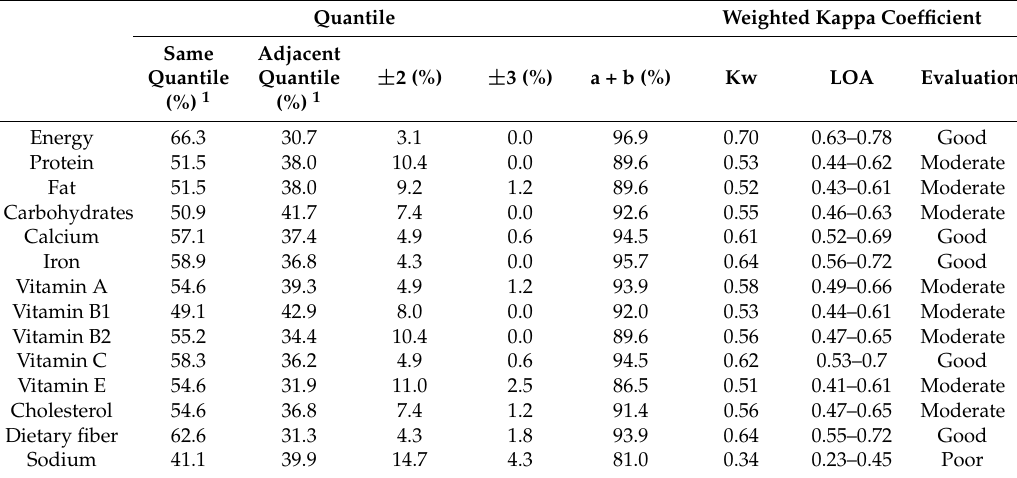
Table 3. Agreement between the DR and WDDR by energy and nutrient intake 1 . Quantile Weighted Kappa